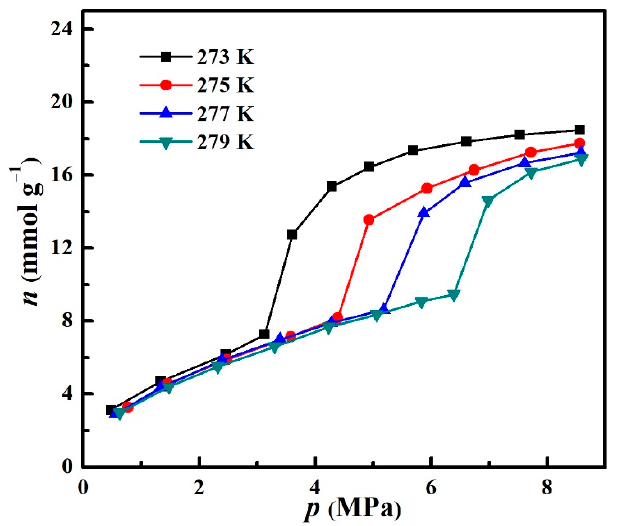
Figure 7. Methane adsorption isotherms of hollow ZIF ‐ 8 nanoparticles ( R W = 0.8) at different temperatures.